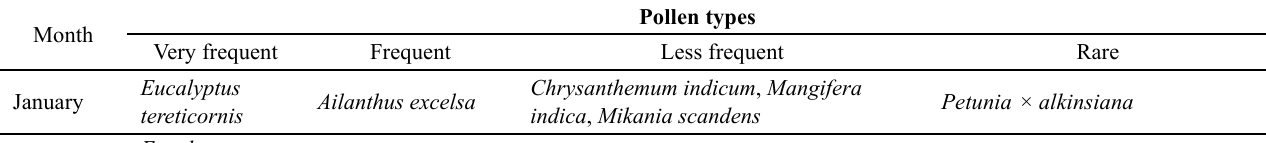
Table 4. Month-wise pollen types obtained from bee’s body surface pollen analysis in Midnapore town, West